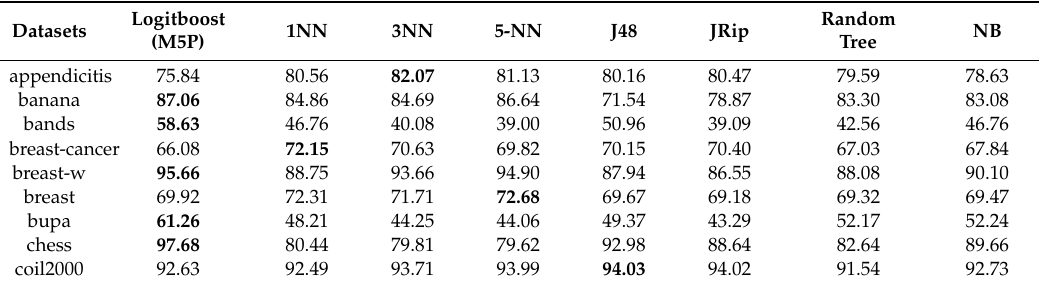
Table 3. Classification accuracy of the Logitboost(M5P) against the selected simple base learners for binary datasets under UncS(Ent) strategy with R =